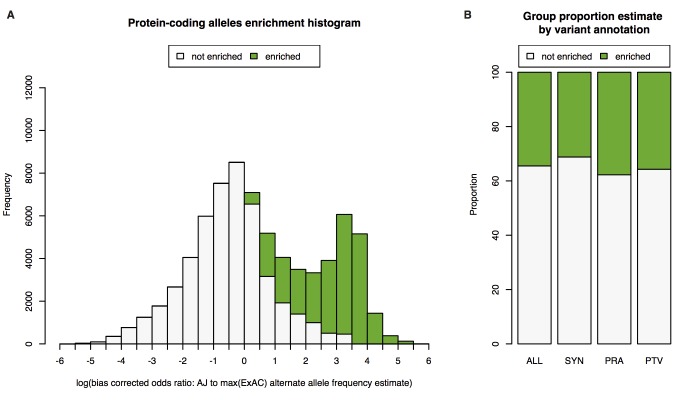
Enrichment of alleles discovered in AJ exome sequencing project.A) Histogram of estimated log enrichment statistic, defined as the log of the bias corrected odds ratio comparing the allele frequency in AJ population to the maximum allele frequency estimated from NFE, AFR, and AMR populations in ExAC. For each histogram bin we show a bar plot of the expected number of alleles belonging to the two groups we analyzed: 1) enriched (green) and 2) not enriched (white). B) Bar plots of estimated percentage of alleles belonging to the two groups we analyzed for all protein-coding (ALL), synonymous (SYN), protein-altering (PRA), and protein-truncating variants (PTV). An estimate of 34% of protein-coding alleles observed in AJ have a mean shift of 15-fold increased odds of the alternate allele compared to other reference populations. This observation is supported by the property that compared to intergenic variants, coding variants tend to be younger for a given frequency and the more pathogenic a variant, the younger it is, therefore tending to be population specific[13].